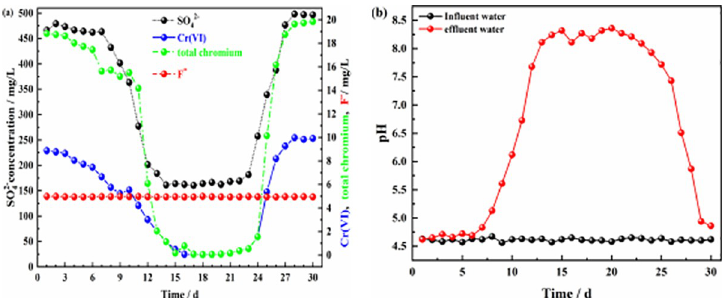
Fig 7. Effluent of dynamic column #2. (a) Effluent concentration of each pollutant ion; (b) pH values of influent and effluent